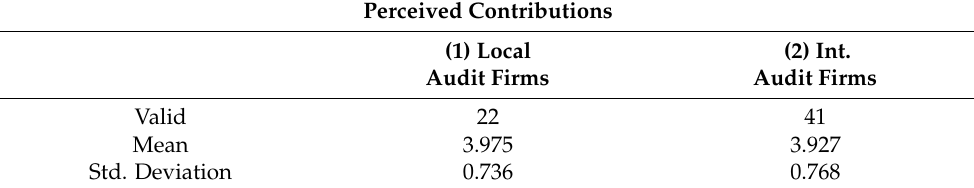
Table 4. Descriptive